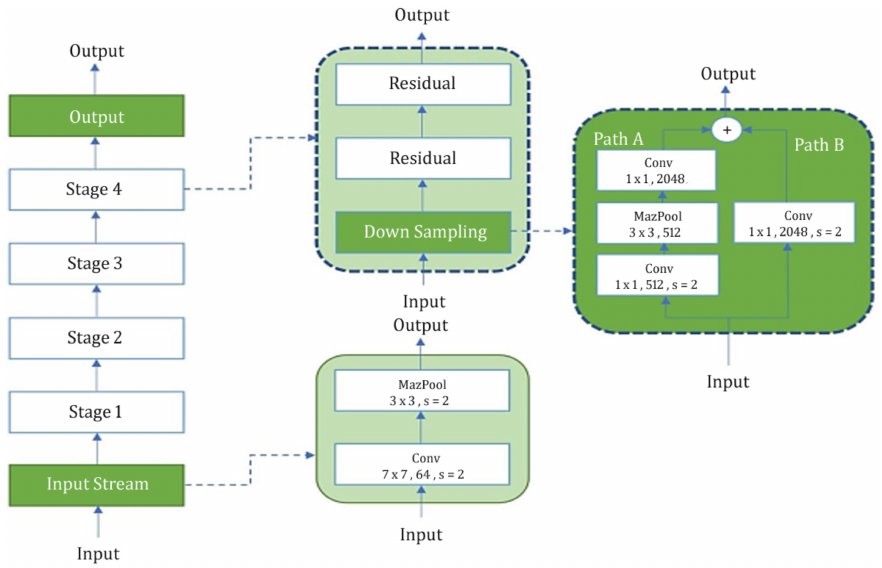
Figure 12. The ResNet Architecture, the convolution kernel size, and output channel size pooling layers. Convolutional layers, an activation unit, pooling, and batch normalization are the key components of ResNet. Figure 13 illustrates these components.